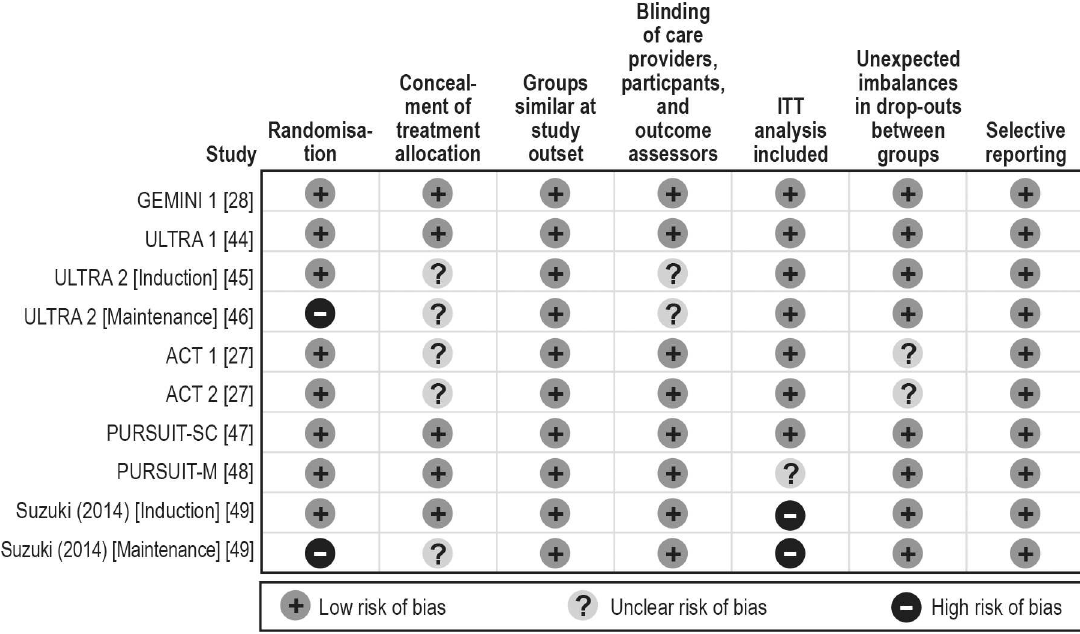
Fig 2. Risk of bias assessment of trials included in the mixed-treatment comparison. ITT,